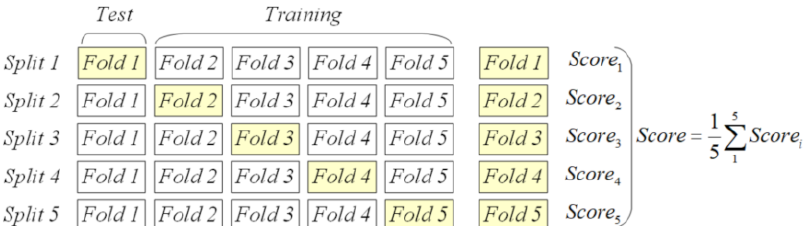
Figure 6. The steps to perform 5 fold CV.